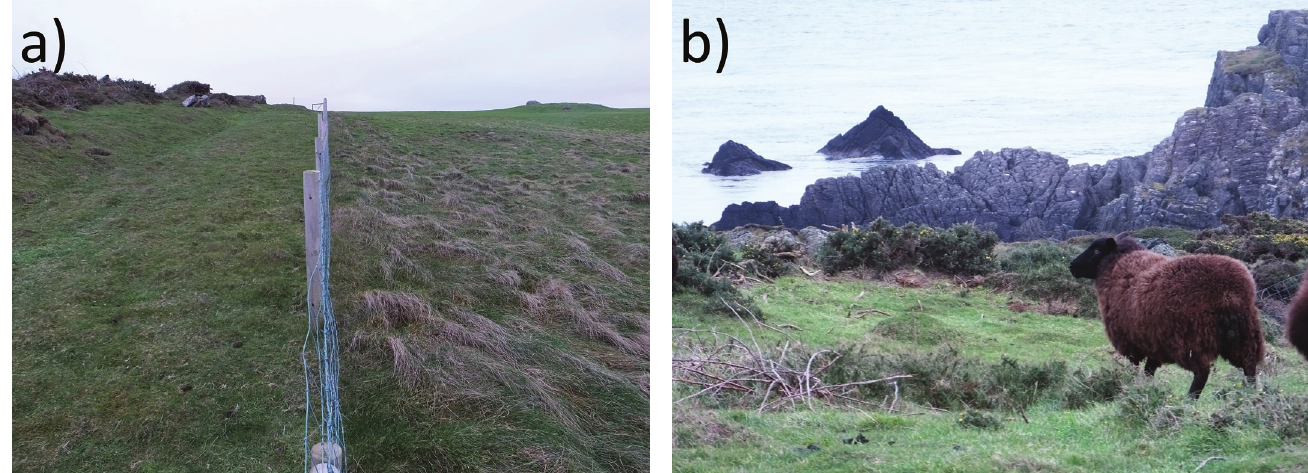
Fig. 3. The impact of targeted grazing in January 2017 after clearance of gorse two years earlier, A. vegetation either side of fencing; B. hardy Welsh Mountain-Texel cross sheep grazing